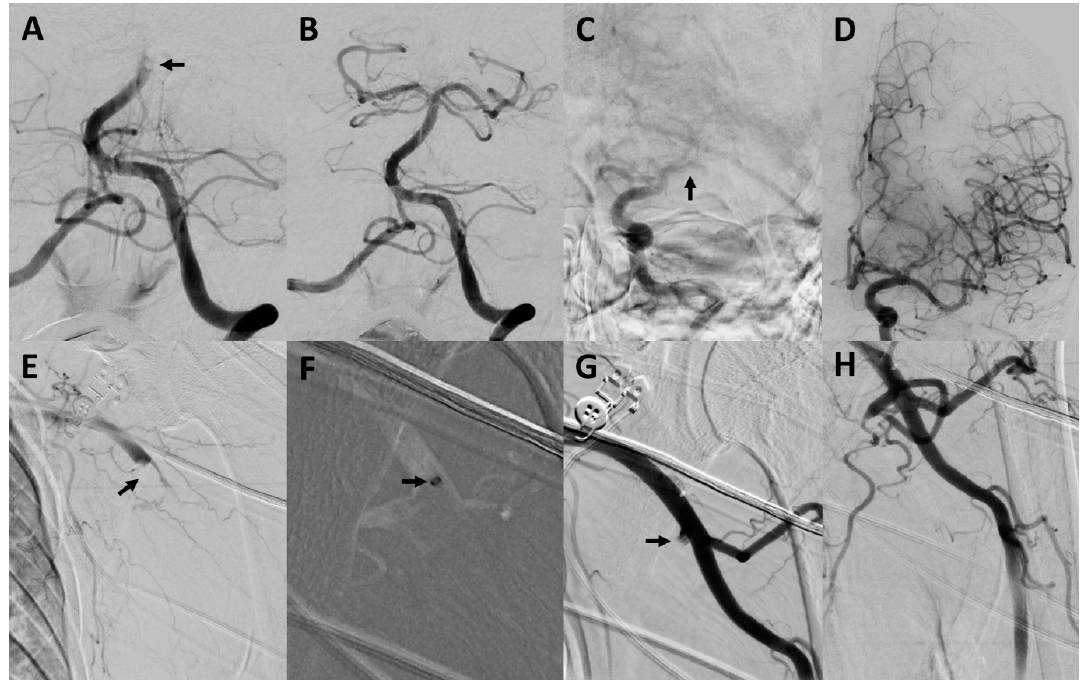
Figure 2. Mechanical thrombectomy of concomitant occlusions of the basilar artery, middle cerebral artery and axillary artery. Patient #3 presented with an occlusion of the distal basilar artery (( A ), arrow), a left-sided occlusion of the M1-segment of the middle cerebral artery (( C ), arrow) and an occlusion of the left-sided distal axillary artery (( E ), arrow). After successful recanalization of the basilar ( B ) and middle cerebral artery ( D ), recanalization of the axillary artery was performed. In total, 4 direct aspiration maneuvers were performed for recanalization (arrow in ( F ) pointing at the tip of a 9F Merci catheter), including an aspiration maneuver for recanalization of the subscapular artery using a 6F Sofia aspiration catheter (arrow in ( G )). An angiogram of the recanalized axillary artery is presented in ( H ).